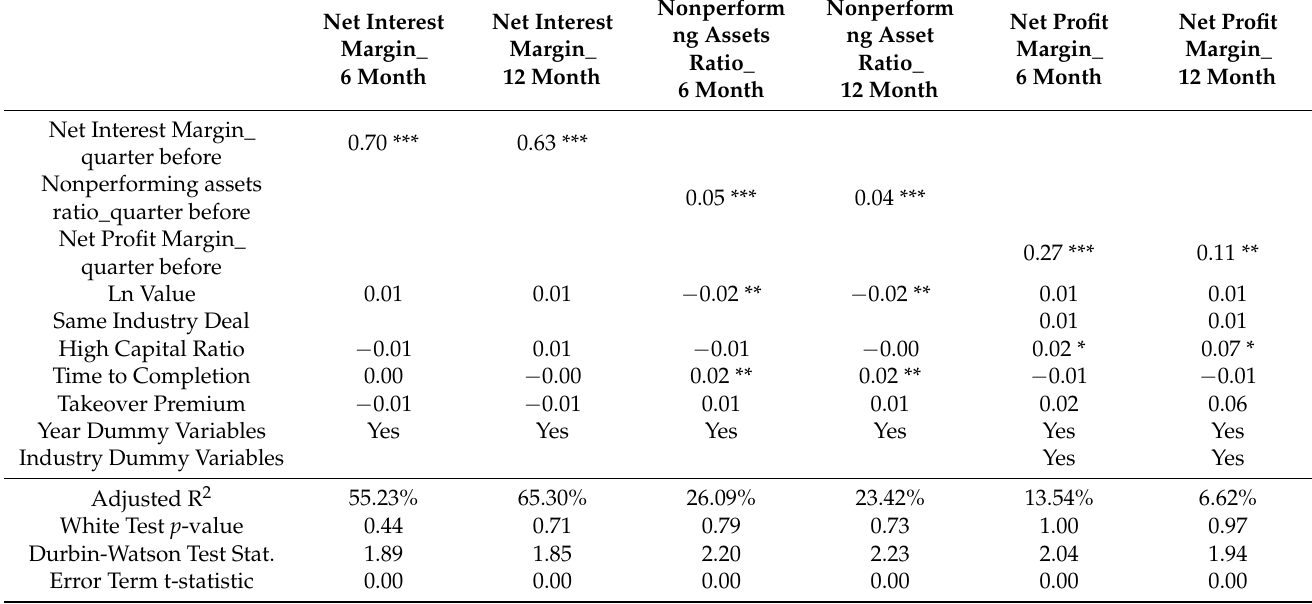
Table 5. Additional Checks: Capital Ratio and Performance. This table reports the regression coeffi- cients and their significance based on firm-clustered adjusted t-statistics, as well as the adjusted R 2 statistic, of specifications explaining bank-specific performance measures—nonperforming assets ratio and net interest margin; and non-bank specific performance—net profit margin. Year and indus- try fixed effects, as appropriate, and deal specific control variables are included. Heteroscedasticity test p -values, Durbin–Watson test statistics, and t-statistics of error terms are reported below the adjusted R 2